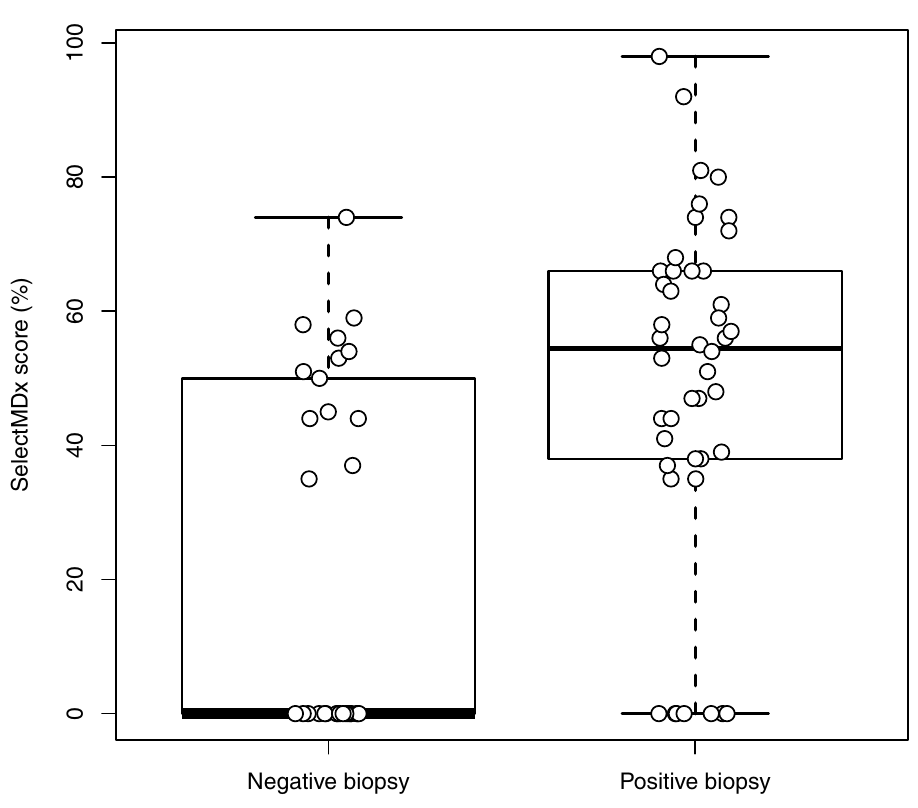
Fig 1. Box plot depicting SelectMDx 1 scores for negative vs. positive biopsy